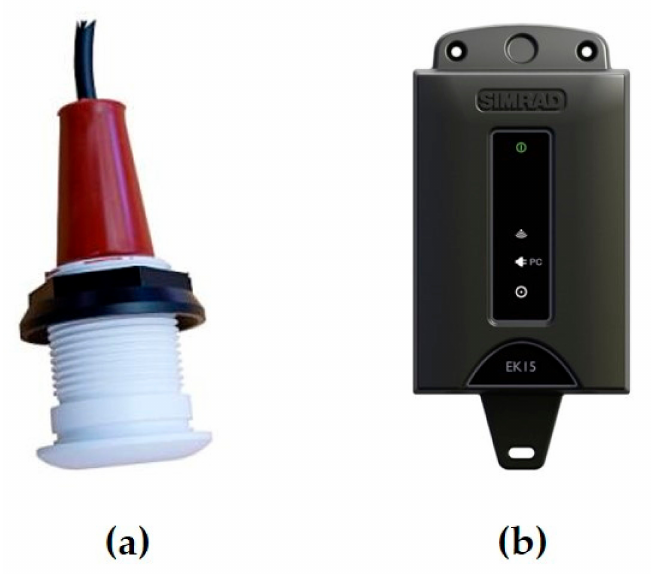
Figure 4. Components of the Simrad EK15 Single-Beam Echo Sounder: transducer ( a ) and transcei- ver unit ( b